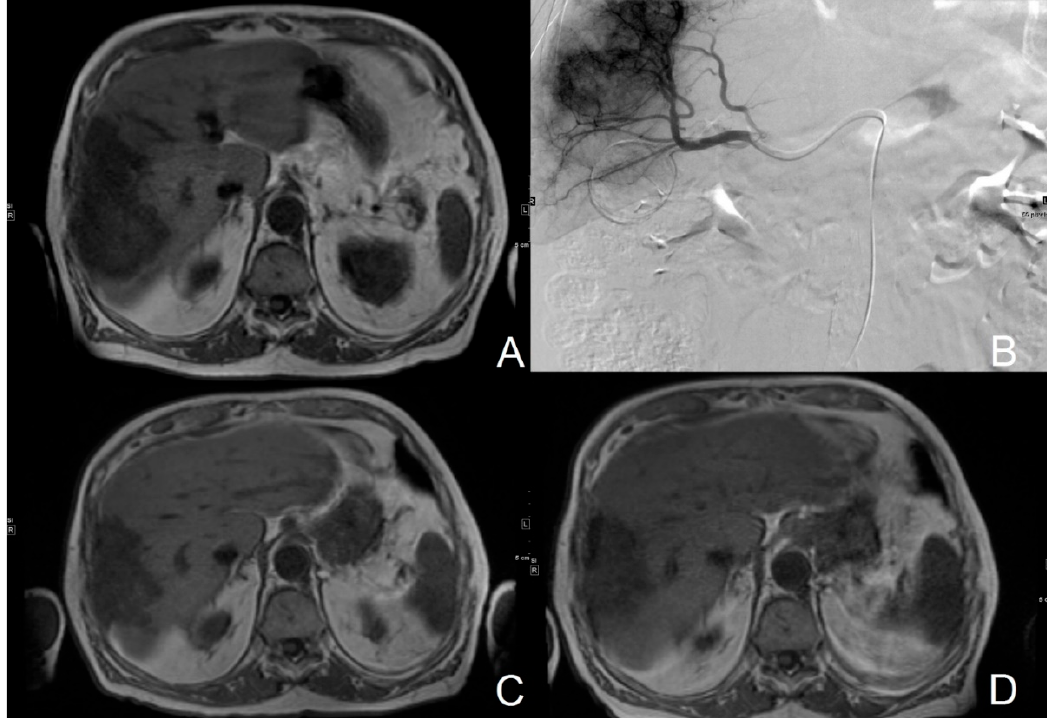
Figure 1. T1-weighted MR images of a 78-year old patient with non-resectable liver metastases of colorectal carcinoma prior to palliative cTACE ( A ). Angiogram during cTACE procedure shows liver metastases ( B ). Repetitive cTACE resulted in stabilization of disease ( C ). 20 months after initial chemoembolization, imaging still showed stabilization of disease ( D ).